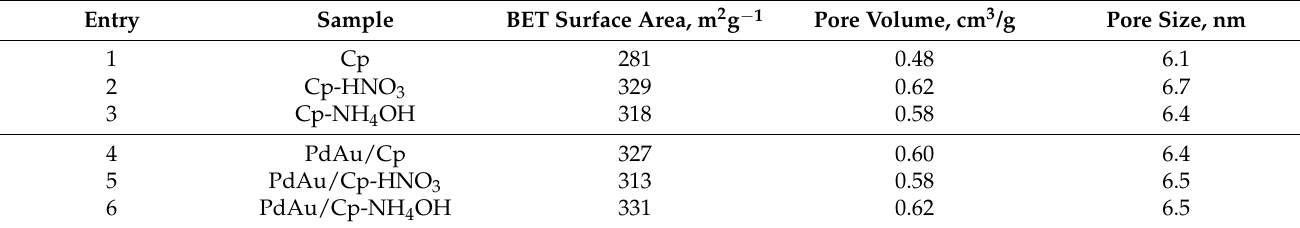
Table 3. Textural properties of catalysts and their corresponding Sibunit supports.